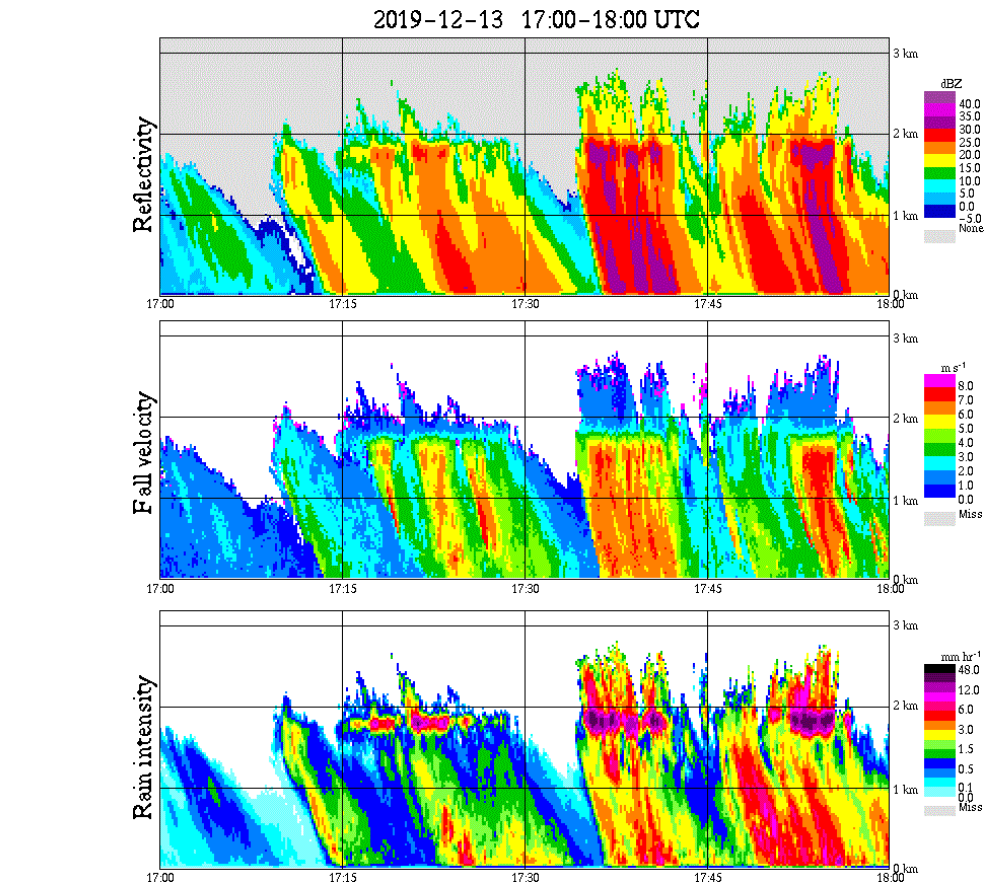
Figure 1. Radar reflectivity (dBz), fall velocity of raindrops (ms − 1 ) and rain intensity (mmh − 1 ) based on Micro Rain Radar measurements in Plymouth (United Kingdom). The vertical axis describes the vertical distance from the sensor and the horizontal axis the time (UTC).